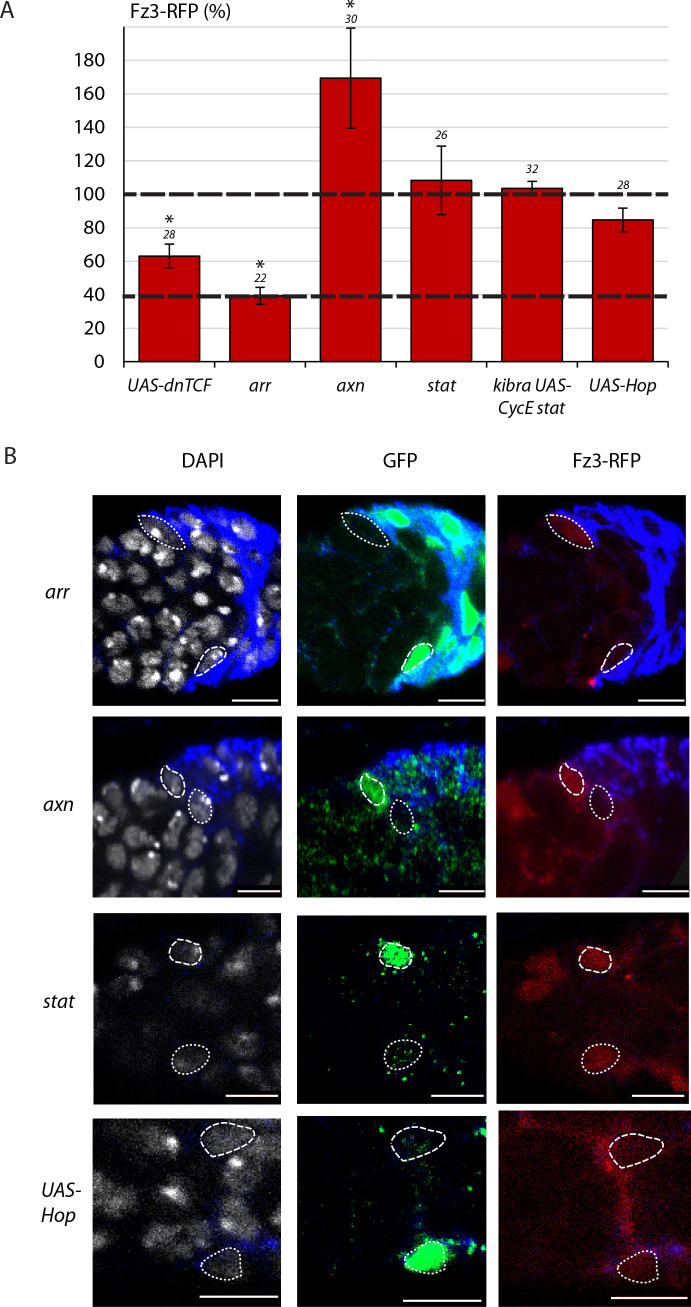
Fz3-RFP intensity is not affected by JAK-STAT pathway activity.(A) Average Fz3-RFP Wnt pathway reporter intensity in MARCM lineages of the indicated genotypes compared to unmarked neighbors at the same AP location and in the same z-section (set at 100% and indicated by the dashed line) with the number of cells measured above the columns. A second dashed line (at 39%) represents the RFP intensity observed in arr mutant cells, which are expected to have no Wnt pathway activity (39%). (B) Images showing the outlines of GFP-positive cells (long dashed line) of the indicated genotypes and their unmarked neighbor (short dashed line) traced from DAPI nuclear staining (white) to evaluate Fz3-RFP (red) intensity. Fas3 (blue) and all scale bars are 10 μm.Figure 5—figure supplement 2—source data 1.Numerical data for graphs in Figure 5—figure supplement 2.